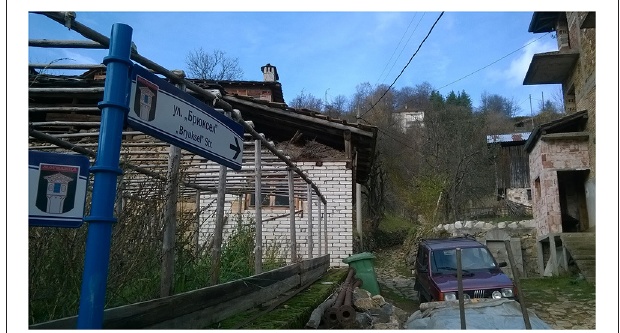
FIGURE 2 | “Brussels street,” the street “of the